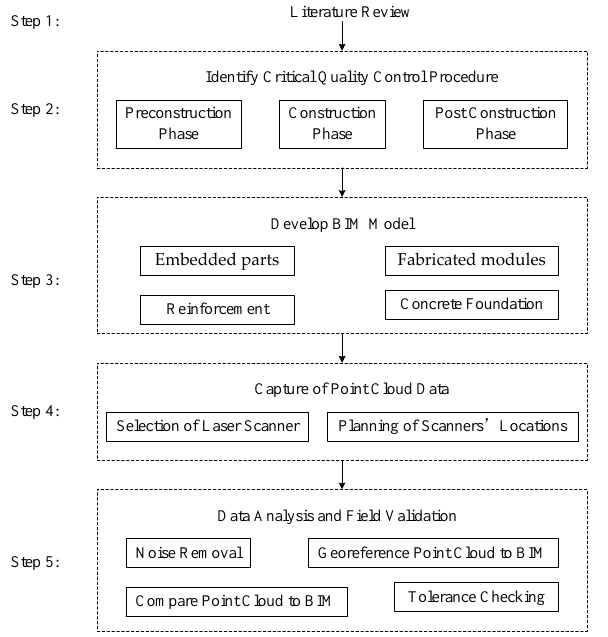
Figure 1. Research framework.